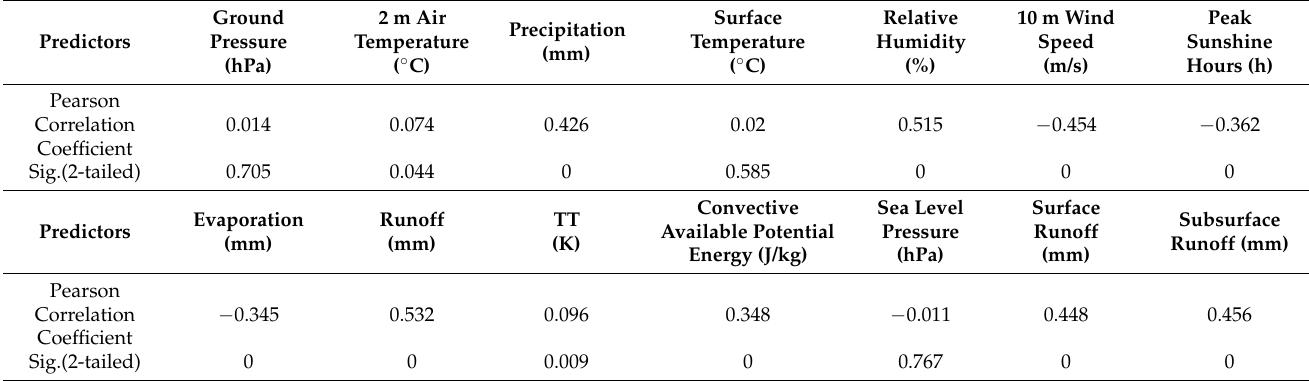
Table 2. Correlation analysis results of candidate